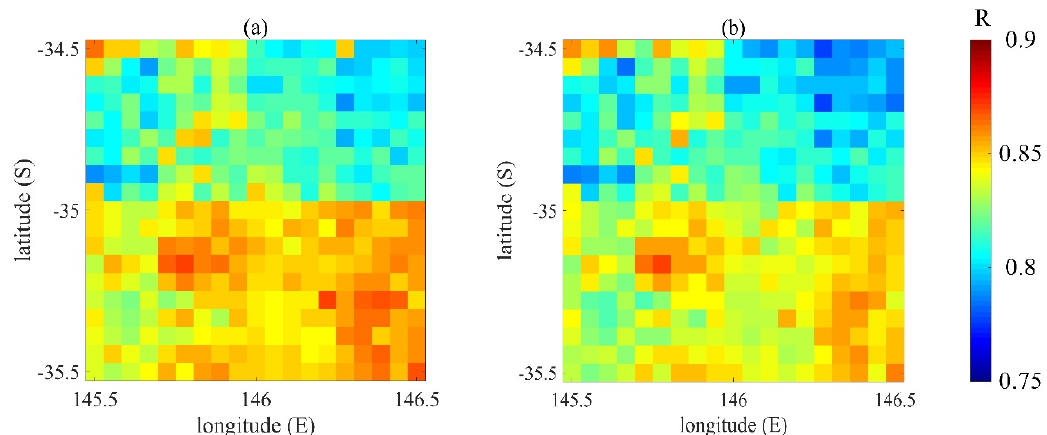
Figure 9. The R between the CCI data and assimilated data using: ( a ) the BGM method; and ( b ) the MC method.